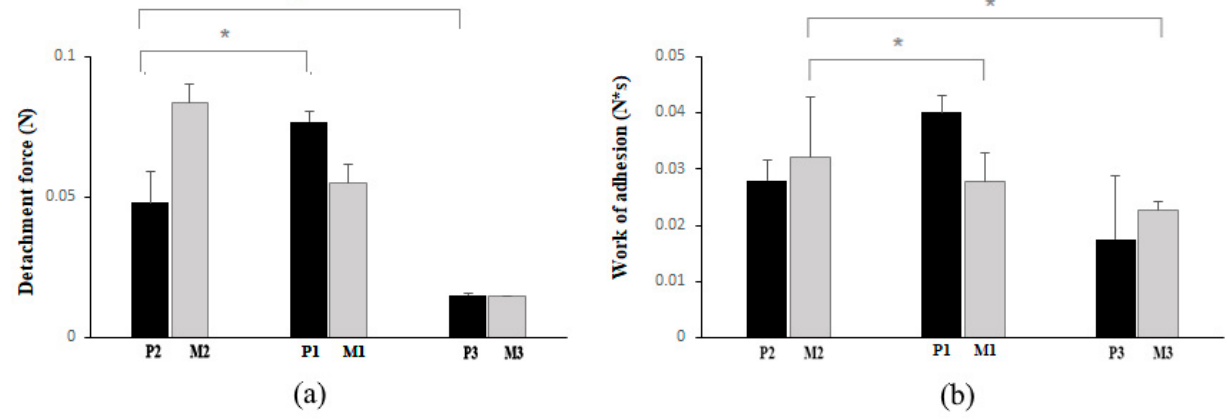
Figure 10. ( a ) Detachment force (N) at pH = 4.5. ( b ) Work of adhesion (N*s) at pH = 4.5. Values were expressed as the mean (SD) from three independent experiments ( n = 3). Each value represents the mean ± standard error mean ( n = 3). * p < 0.05, One-way ANOVA Turkey HSD post hoc test.